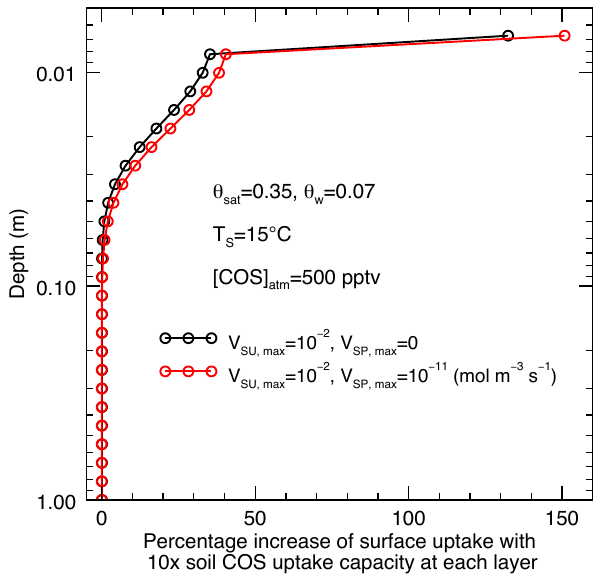
Figure 11. Increase of surface COS uptake (in percentage) from 10-fold changes of V SU , max at each depth. The black line shows the changes for an uptake-only case ( V SU , max = 10 − 2 molm − 3 s − 1 ), while the red line shows the changes when both uptake and source activities are included ( V SU , max = 10 − 2 molm − 3 s − 1 , V SP , max = 10 − 11 molm − 3 s − 1 , but the soil is still a sink). Soil conditions are the same as for Fig.